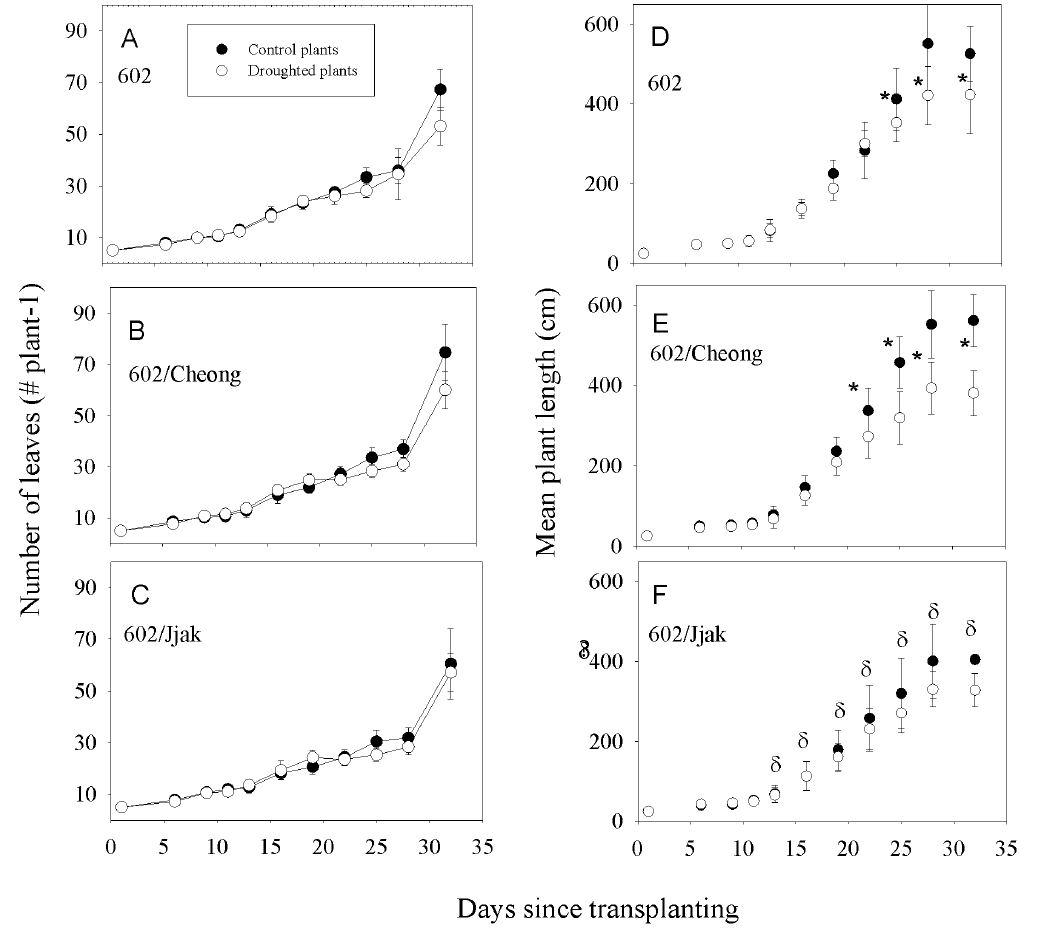
Fig. 2. The total number of mature leaves (A, B, C) and the total plant length (D, E, F) for three different lines of tomato grown with daily watering (control) or daily watering until water was withheld between day 20 and day 28 (mild-drought treatment). 602 5 ‘BHN 602’; 602/Cheong 5 refers